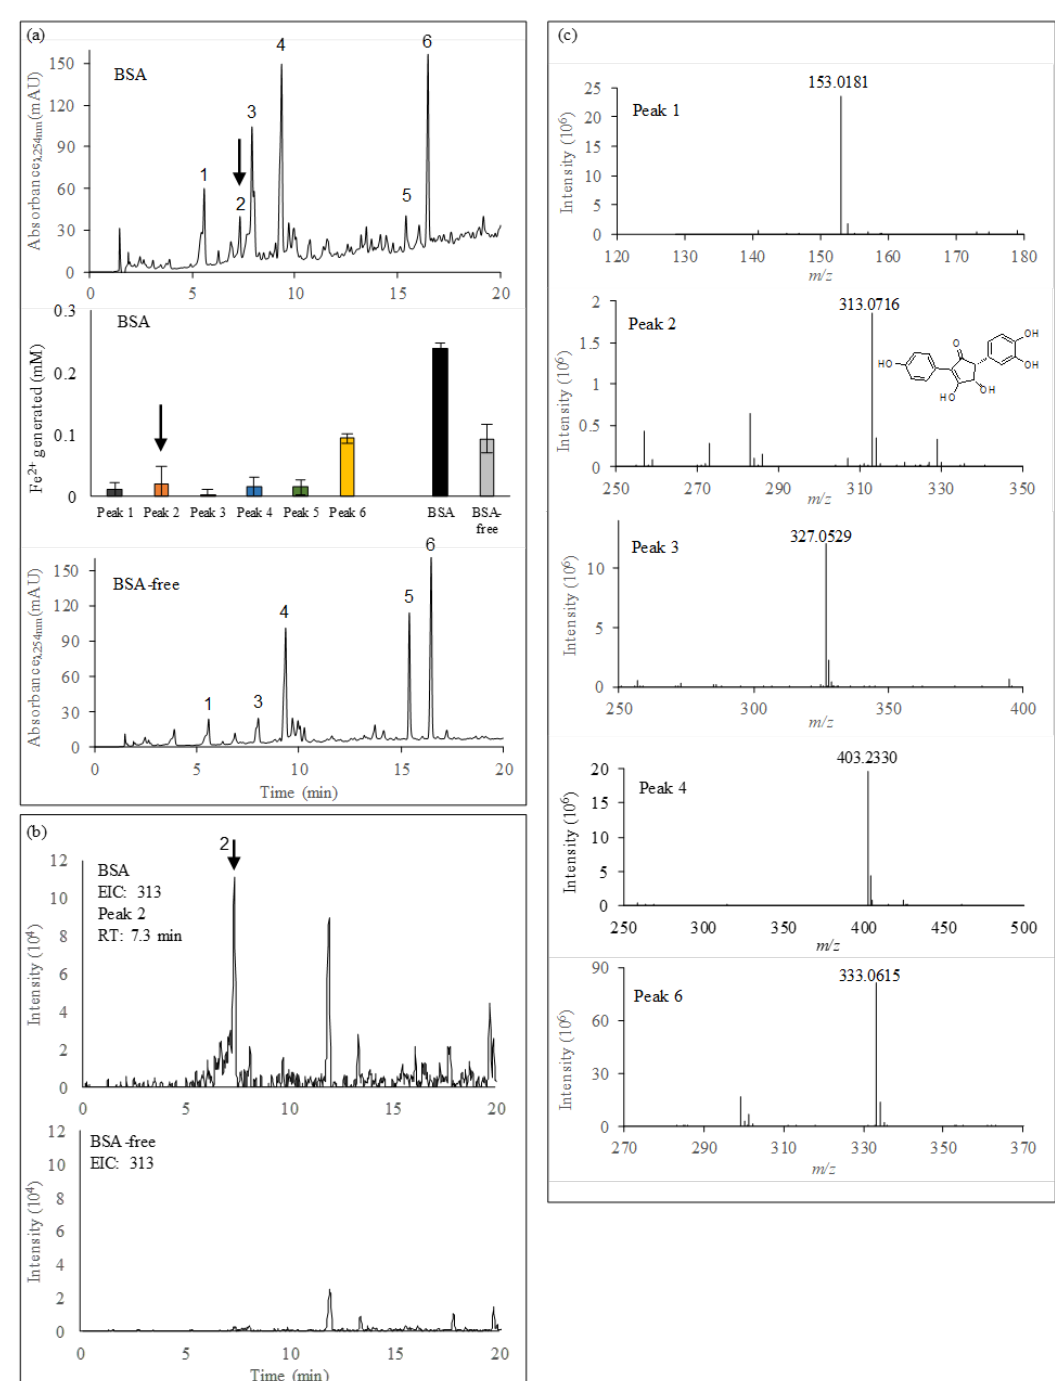
Figure 4. Characterization of iron(III)-reducing metabolites secreted by P. involutus when grown on BSA or BSA-free media for 7 days. ( a ) Top panel: HPLC chromatogram of metabolites extracted by ethyl acetate from the BSA culture filtrates. Middle panel: iron(III)-reducing the activity of peaks 1 to 6 recovered from the BSA culture filtrates. Bars indicate ± standard deviations ( n = 3). Lower panel: HPLC chromatogram of metabolites extracted from the BSA-free culture filtrates. Peak 2 (arrow) was unique to the BSA culture filtrate and was identified as involutin. ( b ) LC-MS profiling (negative ion mode) of the extracts from the BSA-containing (top) and BSA-free (bottom) culture filtrates. The ion chromatogram (EIC) of m/z 313 is shown, which corresponds to the molecular ion of involutin (only detected in the BSA culture filtrates (arrow)). ( c ) HRESIMS spectra (negative mode) of the HPLC identified peaks with iron(III)-reducing activity (c.f. ( a )). Peak 5 was present in the incubation medium lacking BSA and was not analyzed.